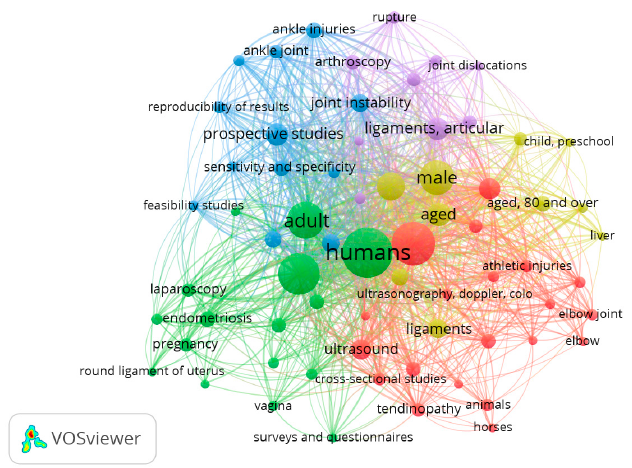
Figure 8. Visualization of keywords for ultrasound examination and ligament.